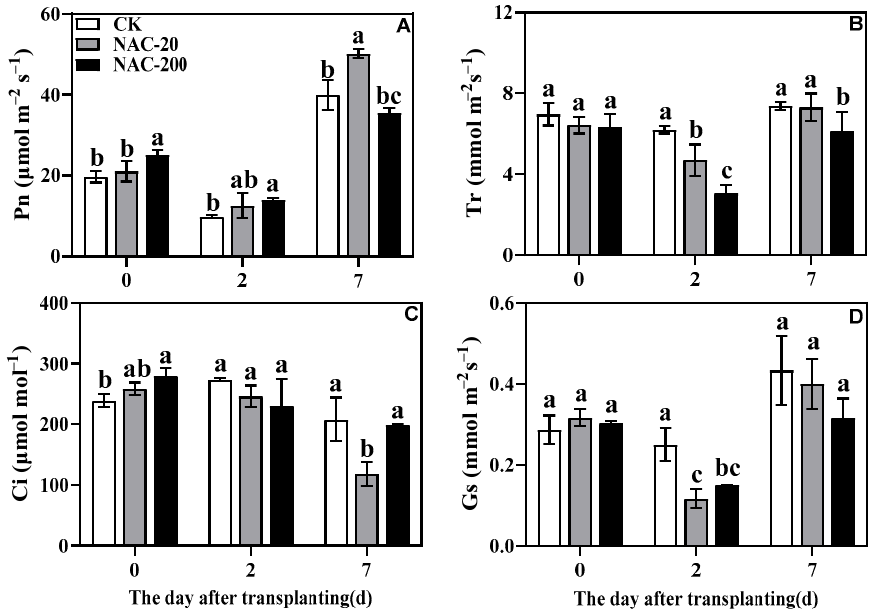
Figure 4. Effects of different concentrations of NAC on chlorophyll ( A ) and carotenoid ( B ) content. CK, 0 μ m; NAC − 20, 20 μ m;NAC − 200, 200 μ m. Data are means ± SD ( n = 3). The different letters following average values indicate significant difference (Duncan, p < 0.05).